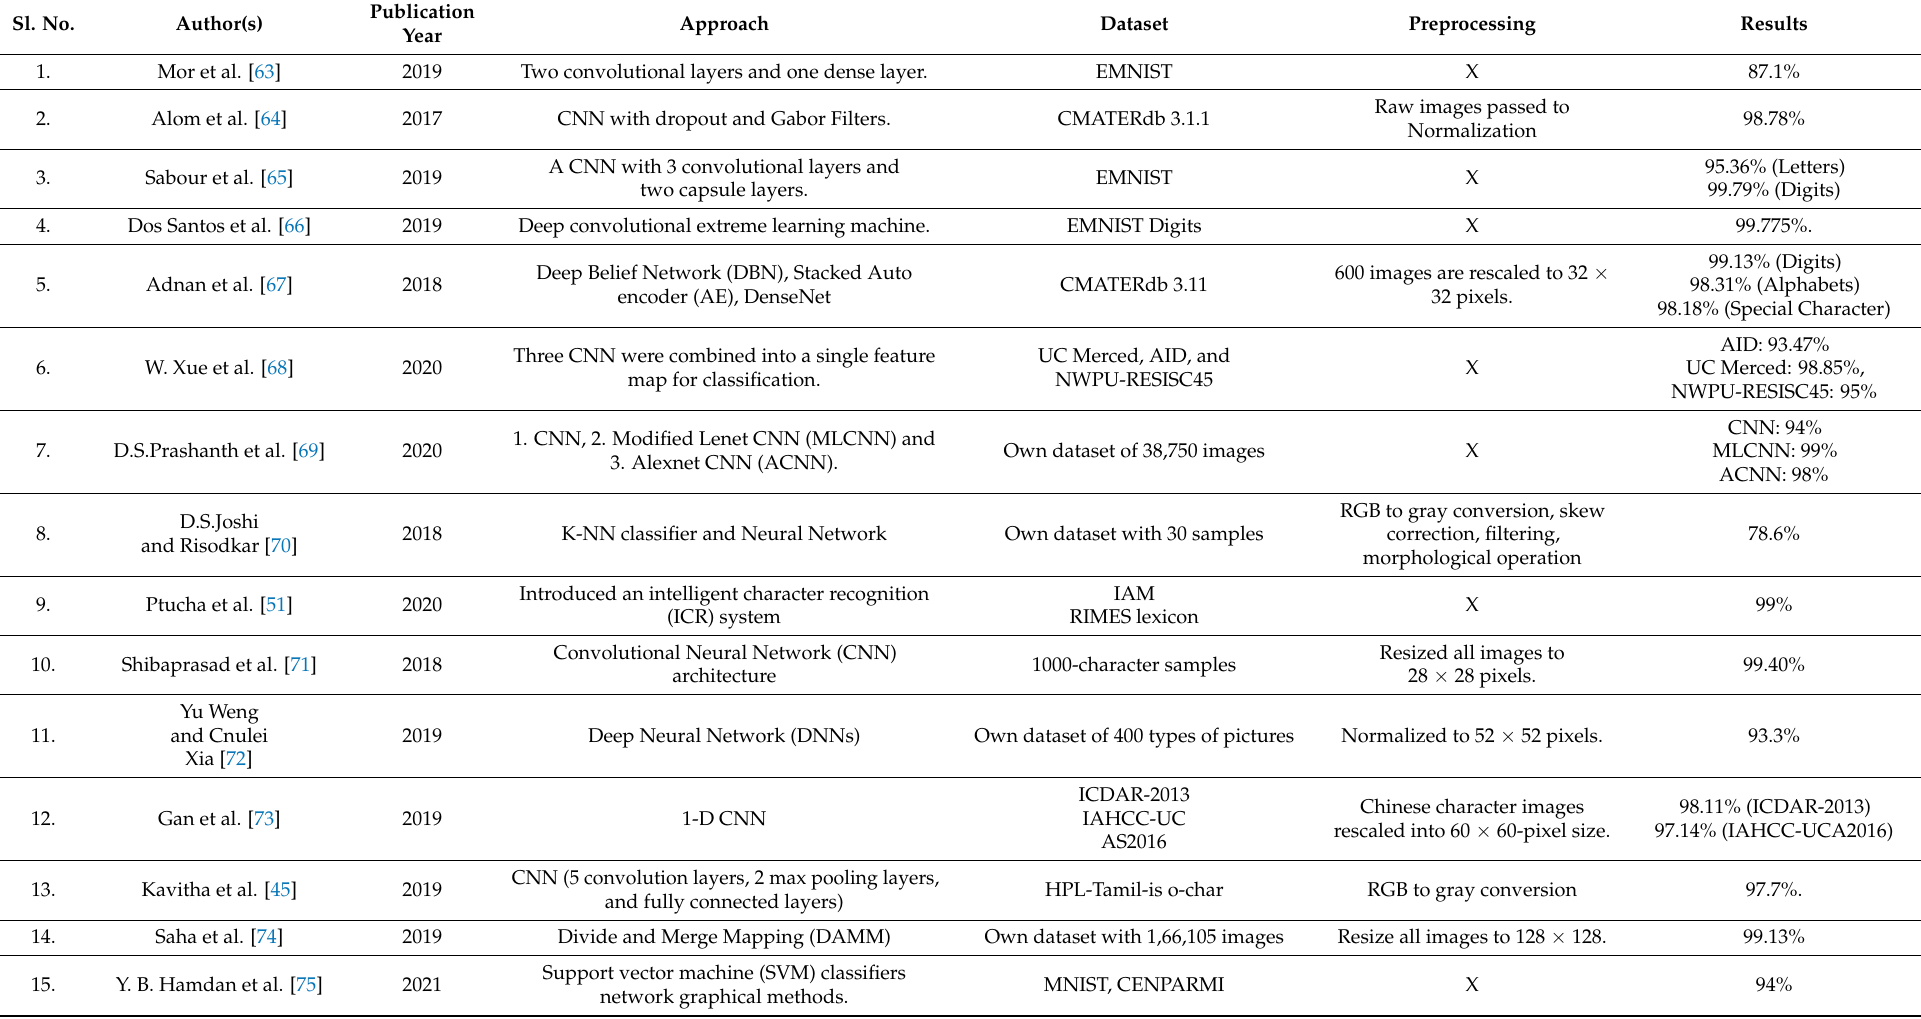
Table 6. Comparison of different learning models’ approaches based on dataset, preprocessing, and accuracy. Sl.